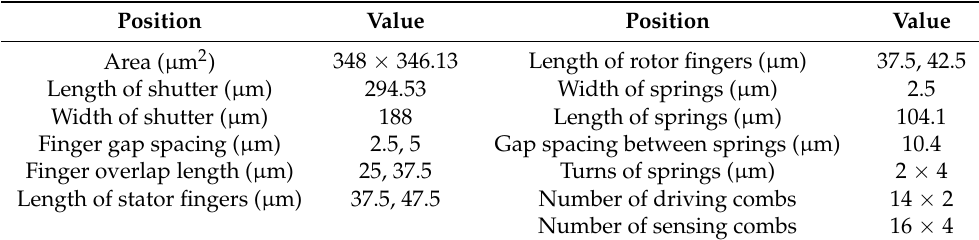
Table 2. Sizes of proposed differential MEMS oscillator.